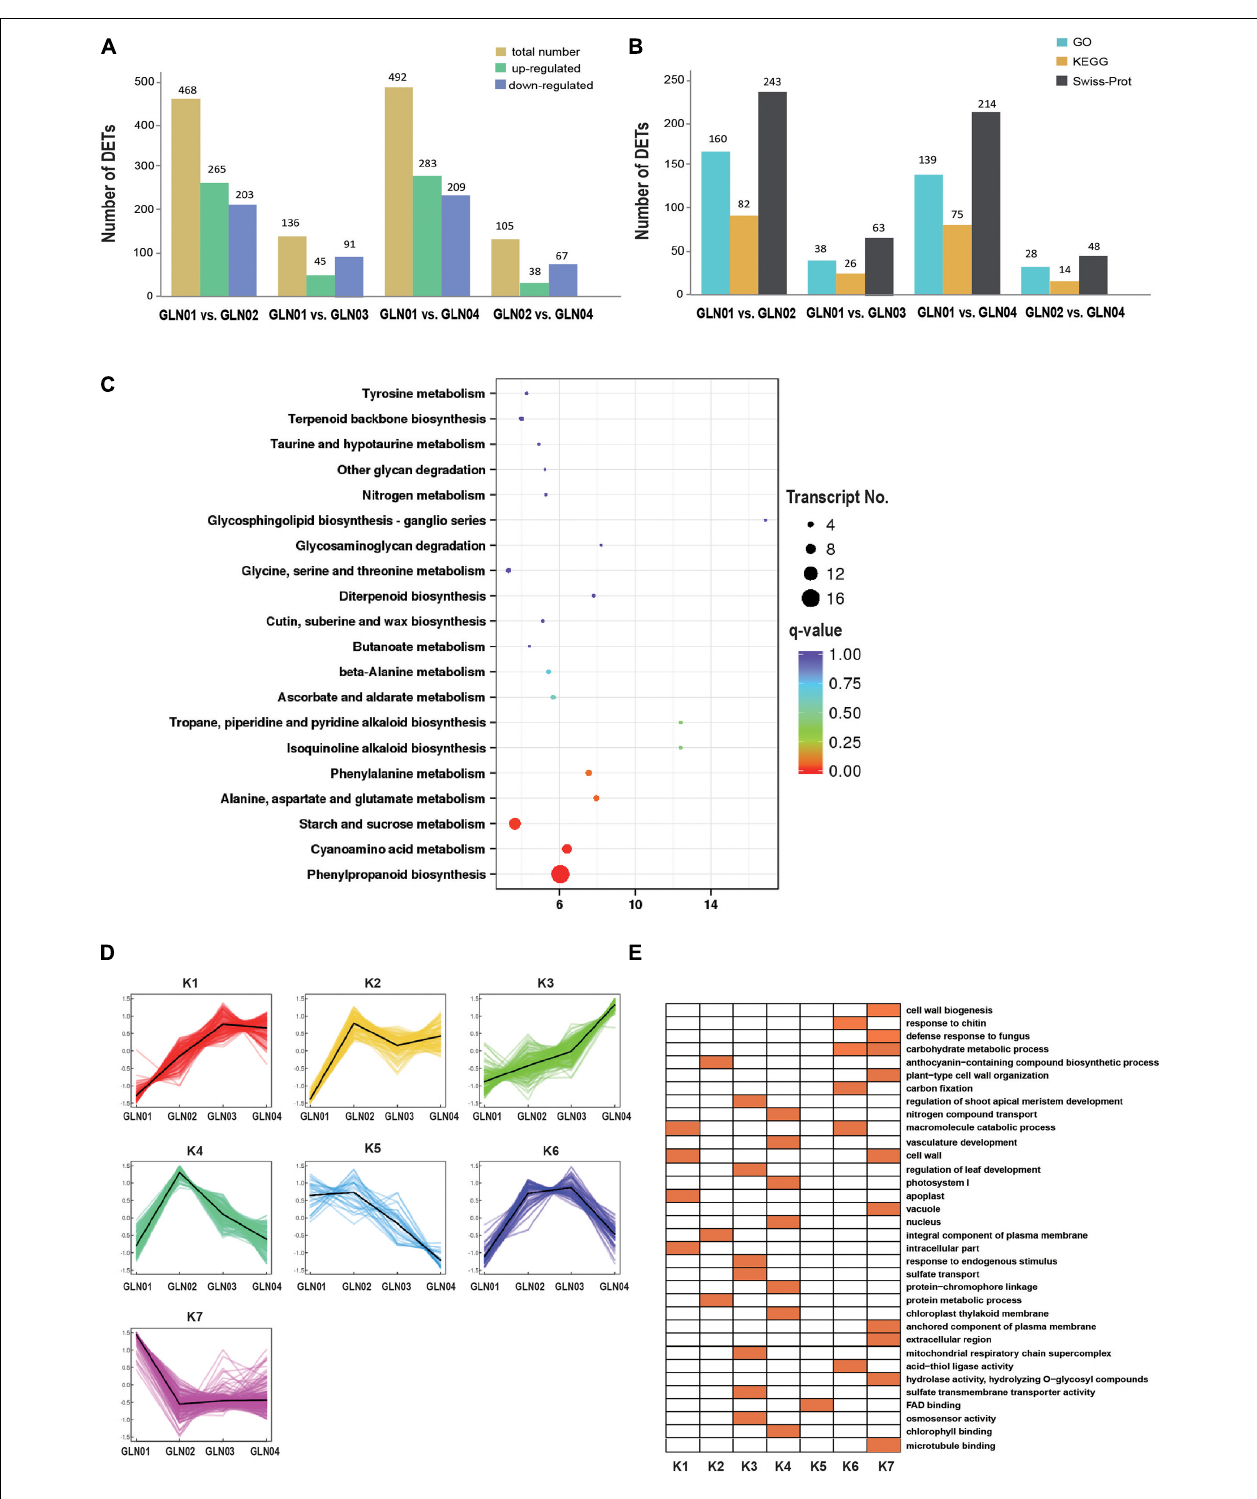
FIGURE 5 | Detected DETs and K-mean clustering analysis of DETs. (A) Numbers of DETs between different developmental stages of G. luofuense stems. (B) Numbers of DETs annotated by the three databases, i.e., GO and KEGG pathway annotations of TFs in the largest three modules, and Swiss-Prot. (C) An air bubble graph showing KEGG pathways enriched in the DEGs between GLN01 and GLN04. Gene numbers (circle size) and enrichment q -values (circle color) are shown. Warm colors represent q -values < 0.05. (D) Seven clusters identified based on expression levels of DETs from GLN01 to GLN04. (E) GO enrichment among the seven clusters with orange boxes denoting significant